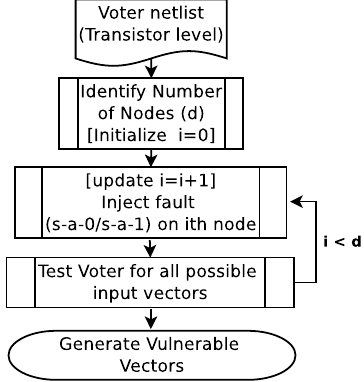
Figure 5. Flow Chart for acquiring vulnerable